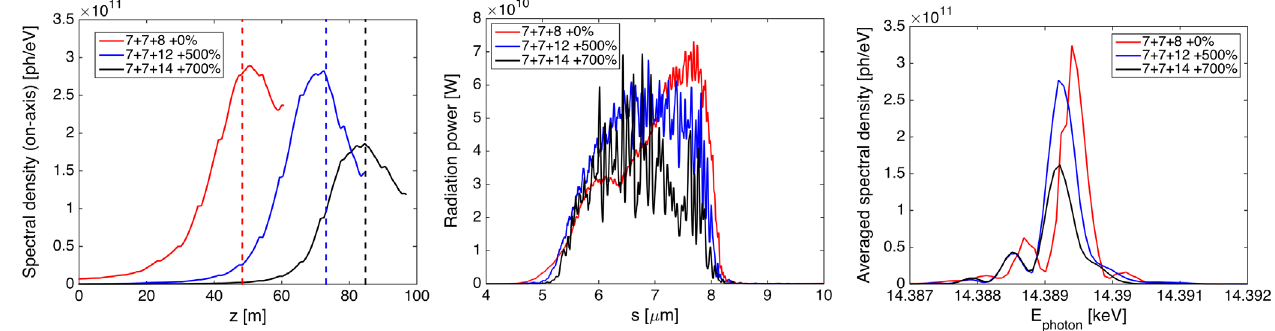
FIG. 11. Maximum on-axis spectral density versus position inside the last radiator (left). Radiation power (middle) and averaged spectral density (right) around saturation for the 7 þ 7 configuration and different percentage increase of the energy spread. All plots refer to a single-shot event. The vertical dashed lines on the left plot show the position where the middle and right plots are plotted.